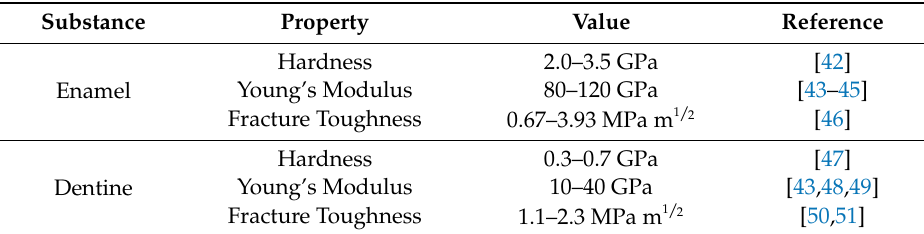
Table 1. Mechanical properties of human tooth enamel and dentine.